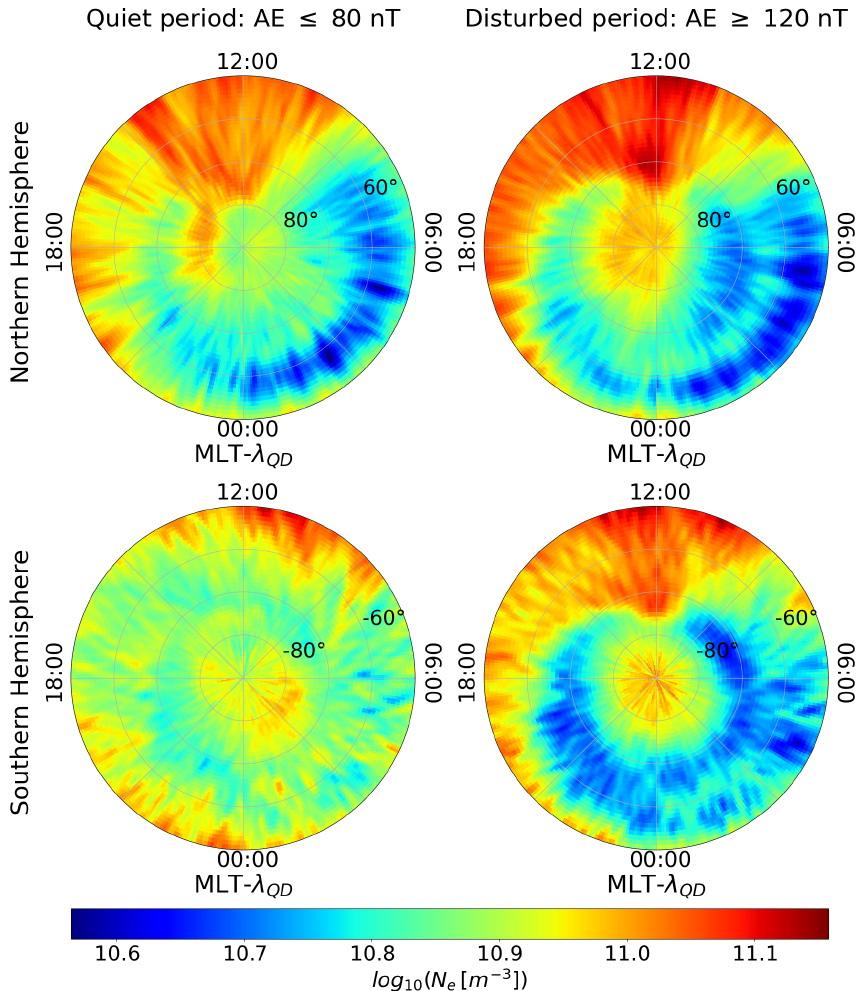
Figure 1. Polar view of the average spatial distribution of electron density ( N e ) for quiet ( left column) and disturbed ( right column) geomagnetic activity conditions, for the Northern and Southern hemi- spheres, in QD-latitude ( λ QD > 50 ◦ and λ QD < − 50 ◦ for the Northern and Southern hemisphere, respectively) and MLT reference system. Maps are obtained using data recorded by Swarm A from 1 April 2014 to 28 February 2018. The concentric dashed circles represent contours of magnetic latitude separated by 10 ◦